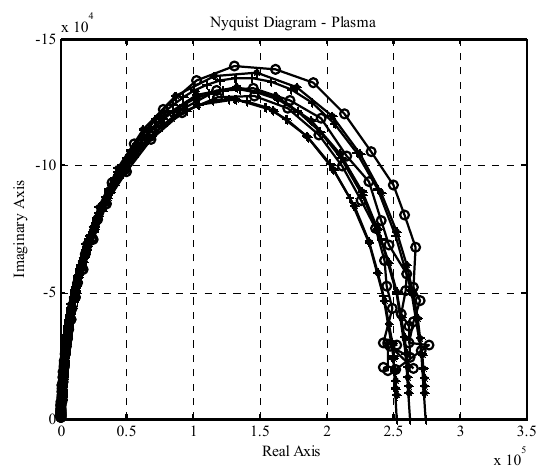
Fig. 10: Nyquist diagram for plasma showing reactance as a function of resistance.